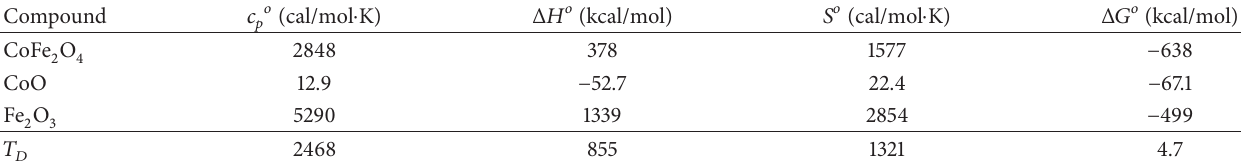
Table 6: Thermodynamic parameters for olivine decomposition at the decomposition